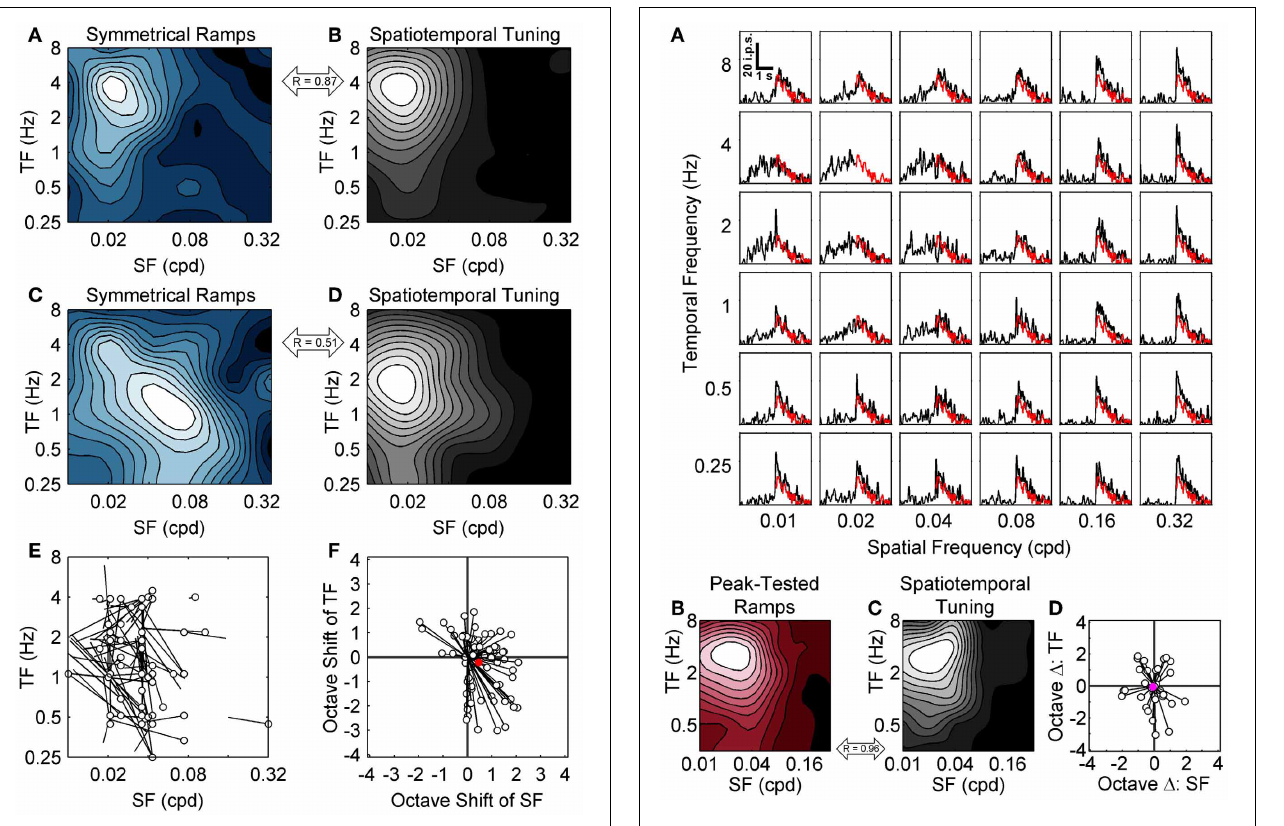
FIGURE 5 | Population data from symmetrical contrast ramp adaptation. The spatiotemporal specificity of adaptation induced with contrast ramps (left column) and spatiotemporal tuning (right column) are compared for two additional sample neurons. As in Figure 4 , contrast ramp hysteresis is shown as blue-tinted contour plots, and spatiotemporal tuning is shown as grayscale contour plots. The contour plots from the neuron in the top row (A,B) match quite closely, indicating that similar grating parameters produced maximum firing and maximum contrast ramp hysteresis. The contour plots from the second neuron (middle row; C,D) match less closely, with the spatiotemporal location of maximum hysteresis occurring at a higher SF and lower TF than the peak in spatiotemporal tuning. The correlations between the contrast ramp and spatiotemporal tuning contour plots are indicated for each neuron (double-headed arrows). (E) shows population data comparing the spatiotemporal location of maximal hysteresis (empty dots) with the locations of peak responding from spatiotemporal tuning (lines). For (A–E) , SF is on the abscissa and TF in on the ordinate. (F) normalized the data from (E) by calculating octave differences in SF (abscissa) and TF (ordinate) to show the location of maximal contrast hysteresis (empty dots) relative to each cell’s spatiotemporal tuning (all normalized to 0). Population mean is shown as a solid red circle.